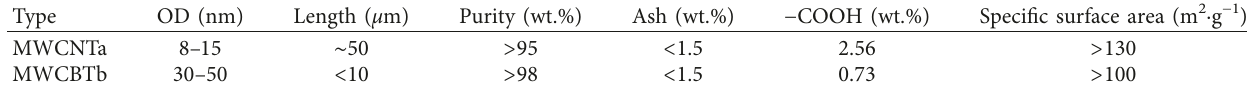
Table 2: Main physical properties of MWCNTs.